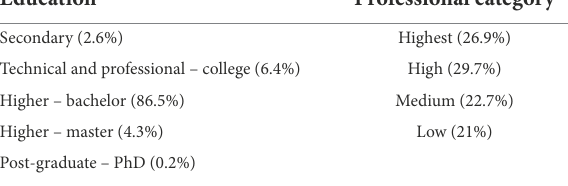
TABLE 1 Distribution of teachers’ answers in categorical variables ( n = 3,029).